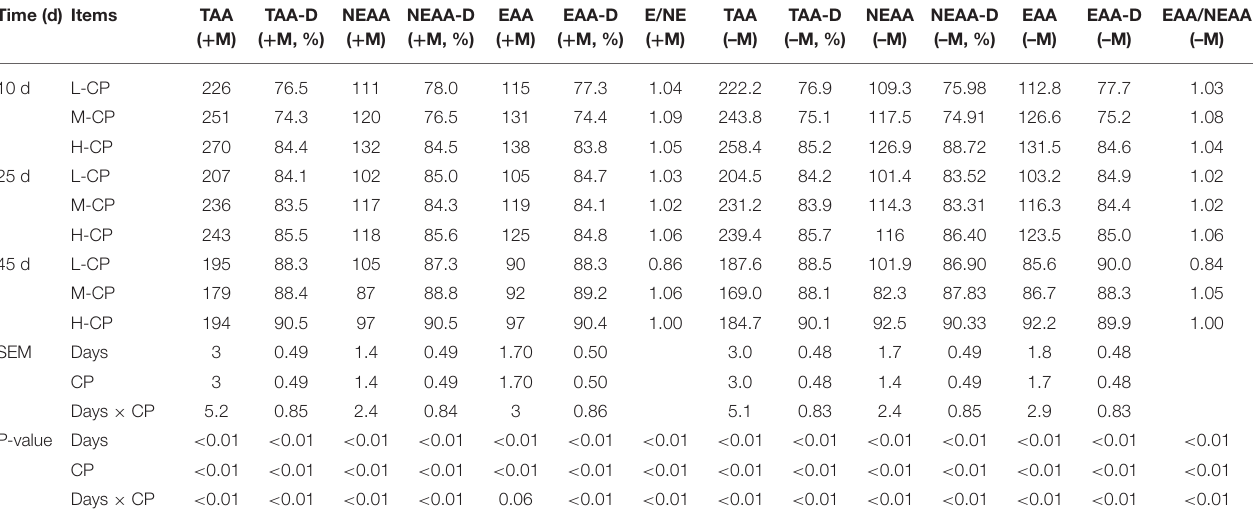
TABLE 3 | Effects of dietary protein levels on the TAA excretion (mg/g DM) and apparent digestibility (%) of piglets. Time (d)